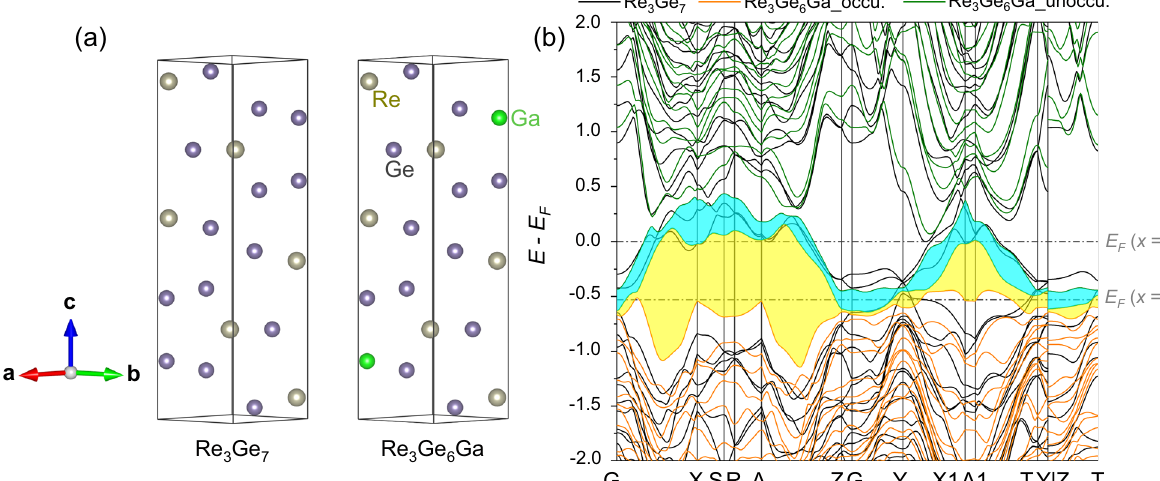
Fig. 7 Hypothetical crystal structure and corresponding electronic structure of Re 3 Ge 6 Ga. a The primitive cell for Re 3 Ge 7 and a possible C 2/ m con fi guration of Re 3 Ge 6 Ga. b Bulk band structure for Re 3 Ge 6 Ga with space group C 2/ m . The cyan and yellow regions correspond to the band fi lling of x = 0 and 1,